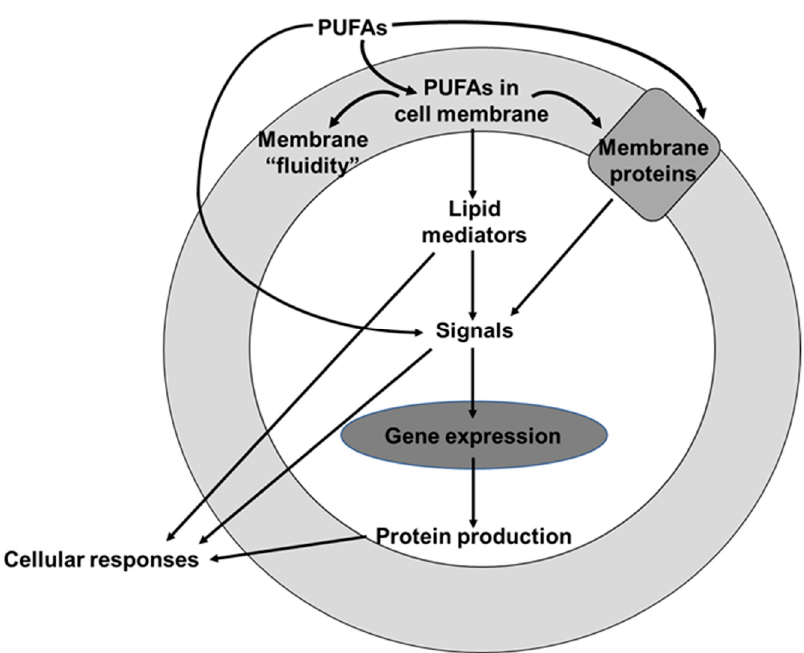
Figure 2. Schematic overview of how polyunsaturated fatty acids (PUFAs) affect cell responses.